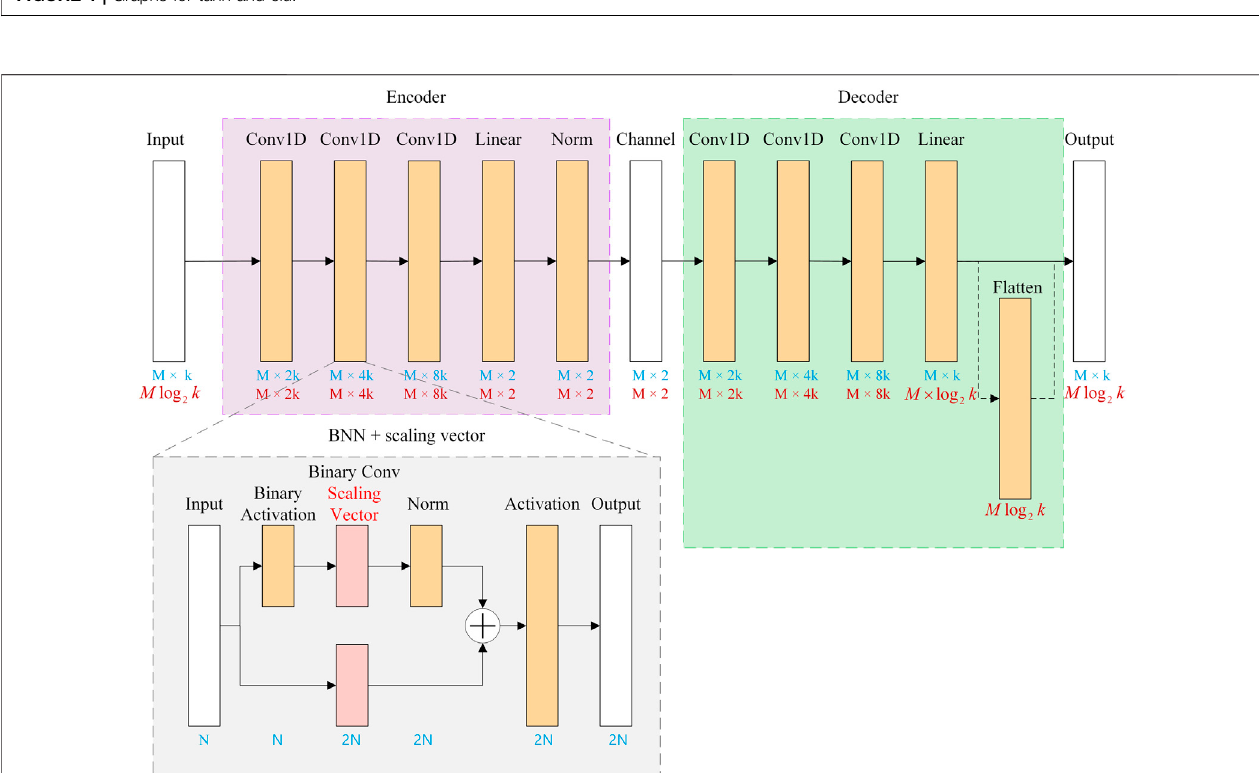
FIGURE 2 | Structure for the encoder and